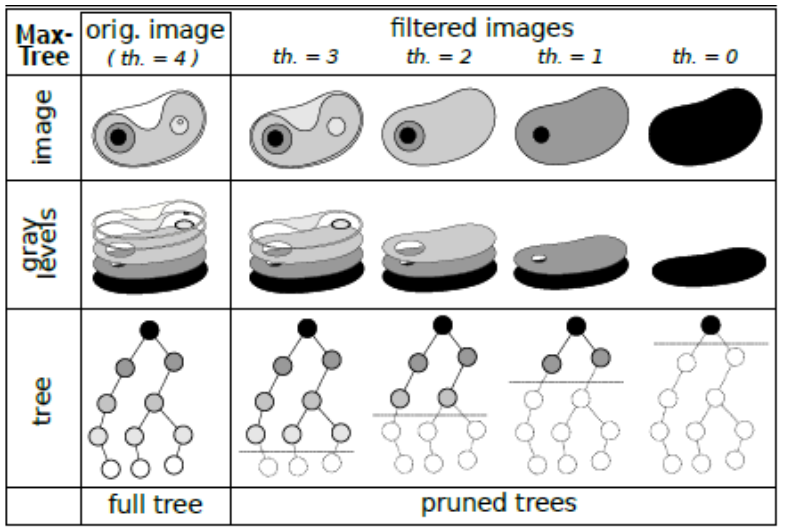
Figure 4. Principle of morphological trees derived from Attributes Profiles (example of Max-tree) to identify objects from the imagery.